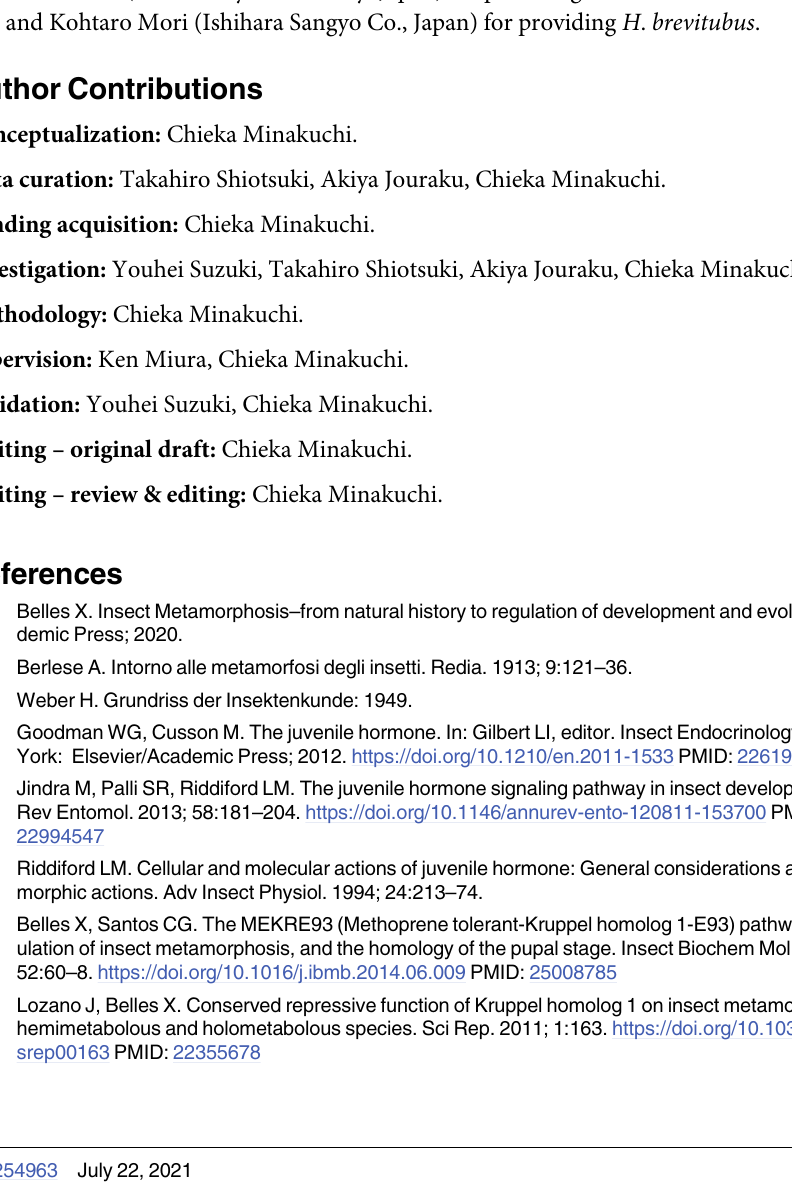
S2 Fig. Alignment of protein sequences of E93 Pipsqueak DNA-binding domains. The pro- tein sequences of E93 were aligned using Clustal Omega (https://www.ebi.ac.uk/Tools/msa/ clustalo/). Fo, Frankliniella occidentalis ; Hb, Haplothrips brevitubus ; Tc, Tribolium castaneum (XP_015839257.1); Bm, Bombyx mori (AIL29268.1); Bg, Blattella germanica (CCM97102.1); Dm, Drosophila melanogaster (NP_652002.2). Dashes in HbE93 sequence represent the part where nucleotide sequence has not been analyzed since RACE PCR has not been performed for H . brevitubus E93 . Three symbols below aligned sequences indicate fully ( � ), strongly (:) and weakly (.) conserved residues, respectively. S1 Table. Primer sequences for RT-PCR and qRT-PCR.